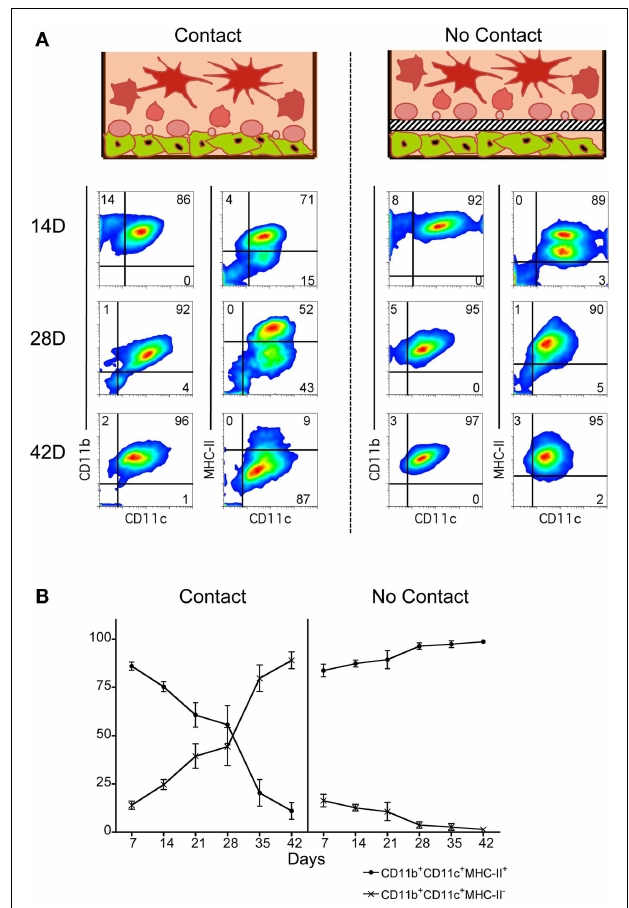
FIGURE 1 | Importance of stromal cell contact for L-DC development. Co-cultures were established in three replicate experiments by overlay of Lin − BM over near-confluent 5G3 stroma with or without aTranswell membrane for a period of up to 42days. Non-adherent cells were collected at 7-day intervals and assessed in terms of cell surface phenotype. (A) Cells were stained with fluorochrome-conjugated antibodies specific for CD11c, CD11b, and MHC-II, or with isotype control antibodies. FSC and SSC analysis was used to gate large (FSC hi ) cells (not shown) for subsequent multichannel analysis. Isotype controls were used to set gates indicating background antibody binding. Numbers shown in quadrants represent % positive cells. Data shown reflect one representative experiment out of three. (B) The relative proportion of MHC-II − and MHC-II + cells amongst CD11c + CD11b + cells produced in co-cultures was estimated. Data represent mean ± SE ( n = 3 replicate